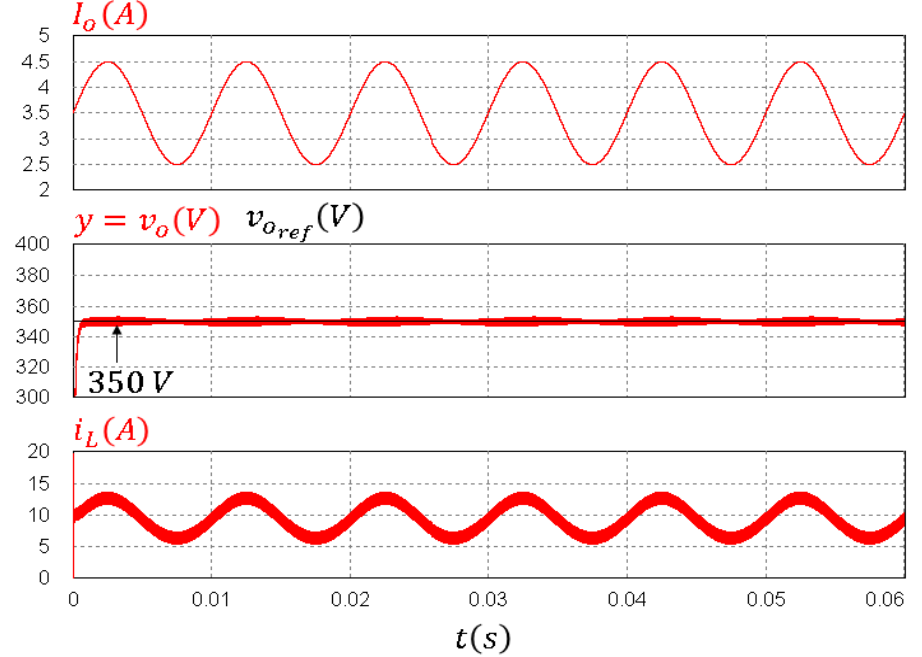
Figure 6. Response to a periodic disturbance in the output current i 0 .